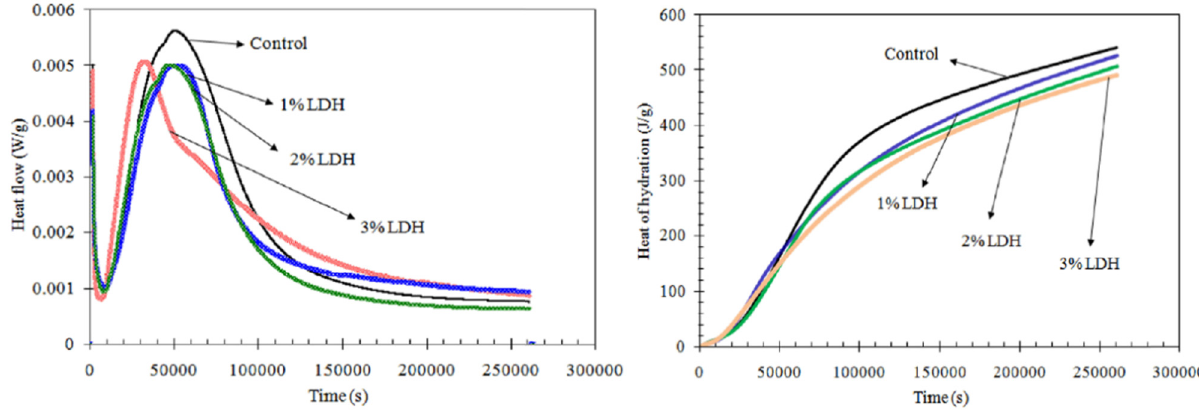
Figure 9: Hydration heat fl ow and total heat released from cement pastes with LDHs [ 106 ]